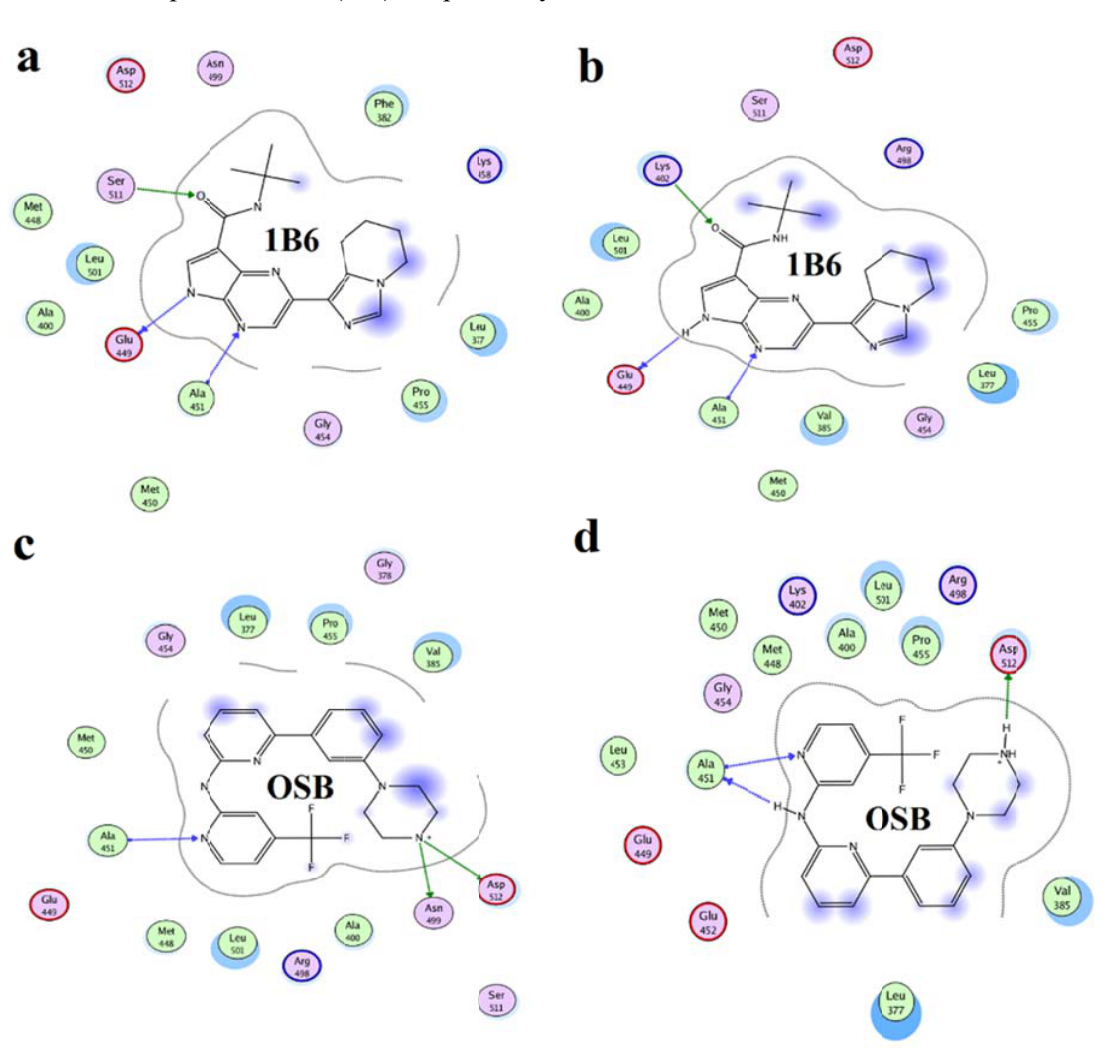
e 7. The shown structu